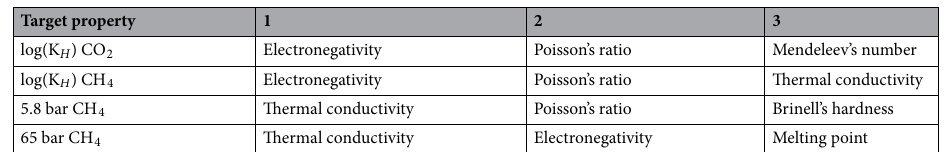
Table 5. Material properties sharing overlap with word embedding feature importances. Machine learning models trained with elemental word embeddings and materials properties are compared to the models trained with MOF composition word embeddings and MOF target properties for the CoREMOF dataset. The feature importances of each model are analyzed, and compared by Jaccard similarity. The top three materials properties most similar to the model trained to MOF target properties are